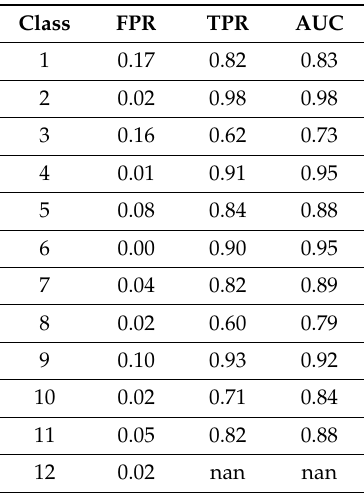
Table 9. Obtained TPRs vs. FPRs, for ROC curves, from the well trained and tested feed-forward, multilayer ANN applied on the class-imbalanced test data; for the 12 classes the AUCs obtained are also shown.